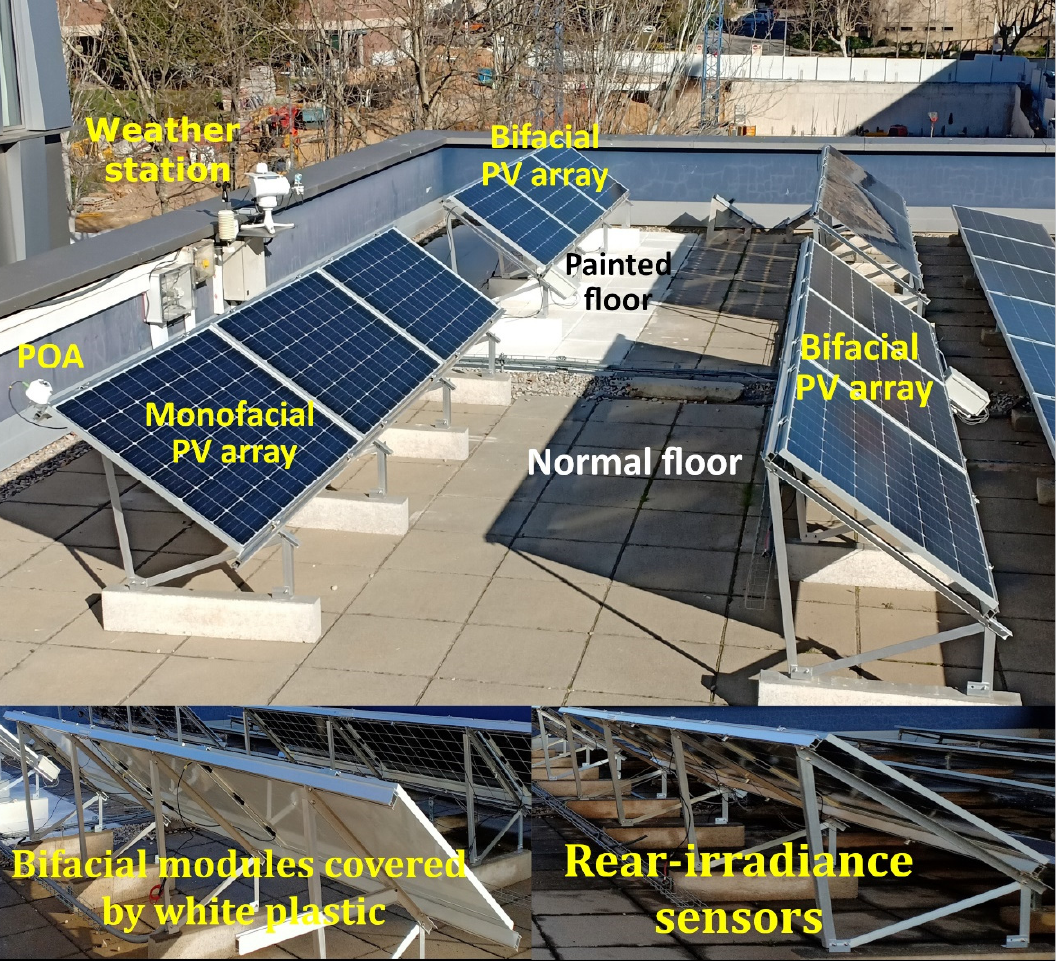
Figure 1. Bifacial installation on the rooftop of the UPC in Terrassa. Monofacial with backside covered by white plastic, bifacial with normal albedo, bifacial with high albedo, and white painting applied to the floor. The rear irradiance was measured by five sensors installed on the top, middle, and bottom. Before mounting the bifacial PV modules, the albedos were measured, and we found 15% for the normal floor and 32% for the painted floor.